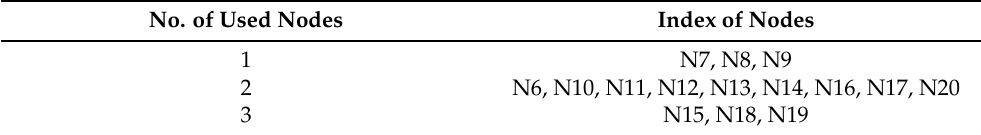
Table 15. Number of processing nodes used.